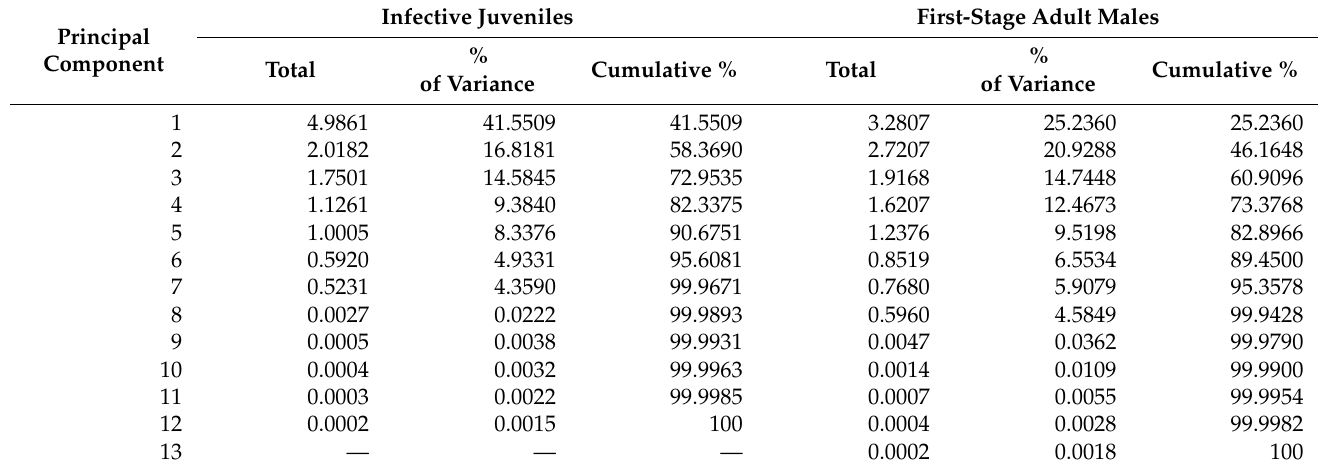
Table 9. Initial eigenvalues from PCA for infective juveniles and first-stage adult males.